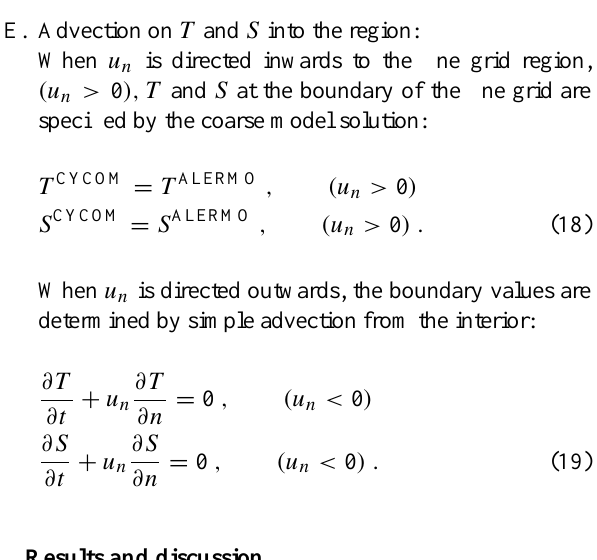
Fig. 7e. CYCOM circulation at 30m, for October of the second year of the climatological